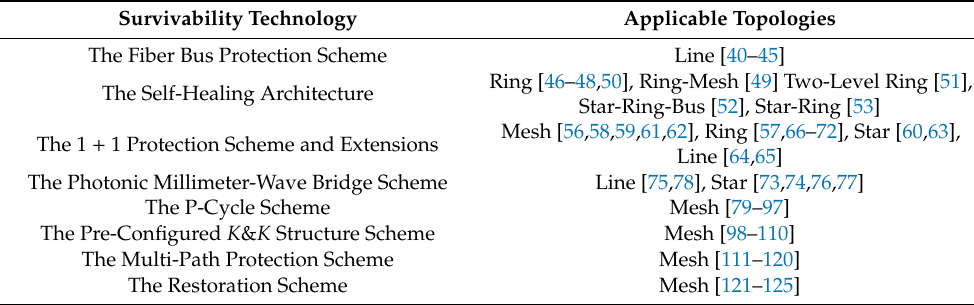
Table 4. The applicable topologies of each kind of survivability